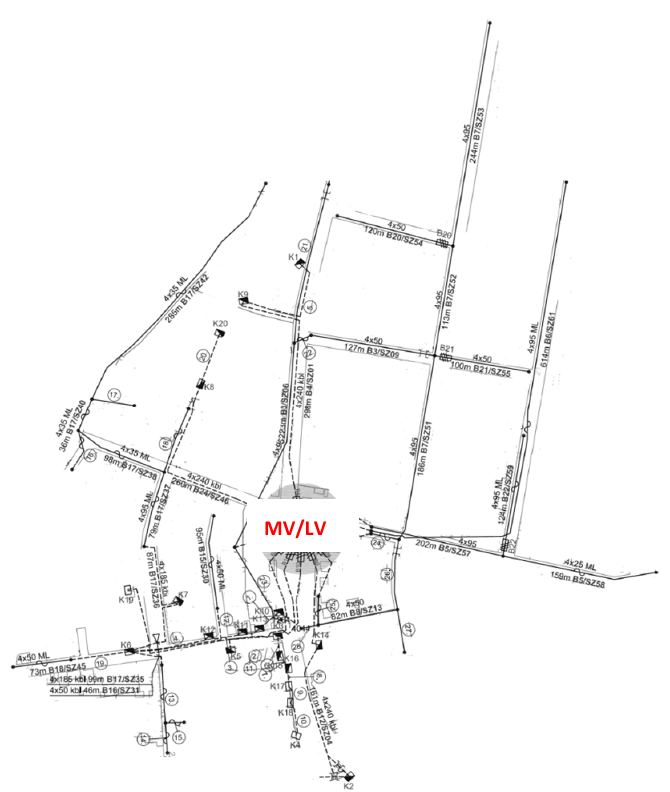
Figure A4. Topology of area 20667 (MV/LV represents the supplying medium/low-voltage trans-